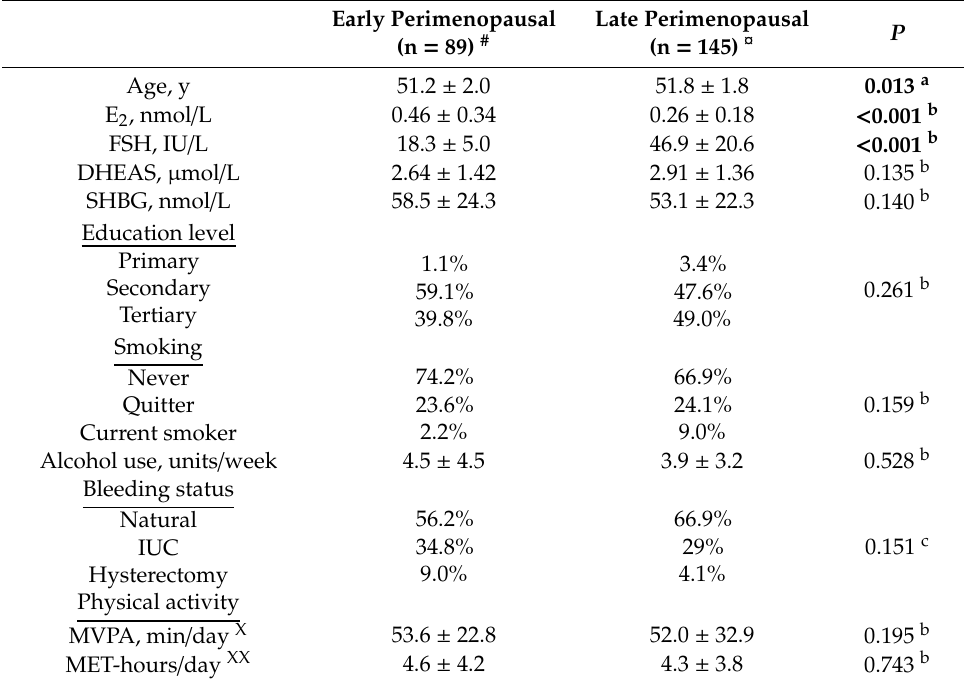
Table 1. Characteristics of the perimenopausal ERMA baseline population (n = 234).